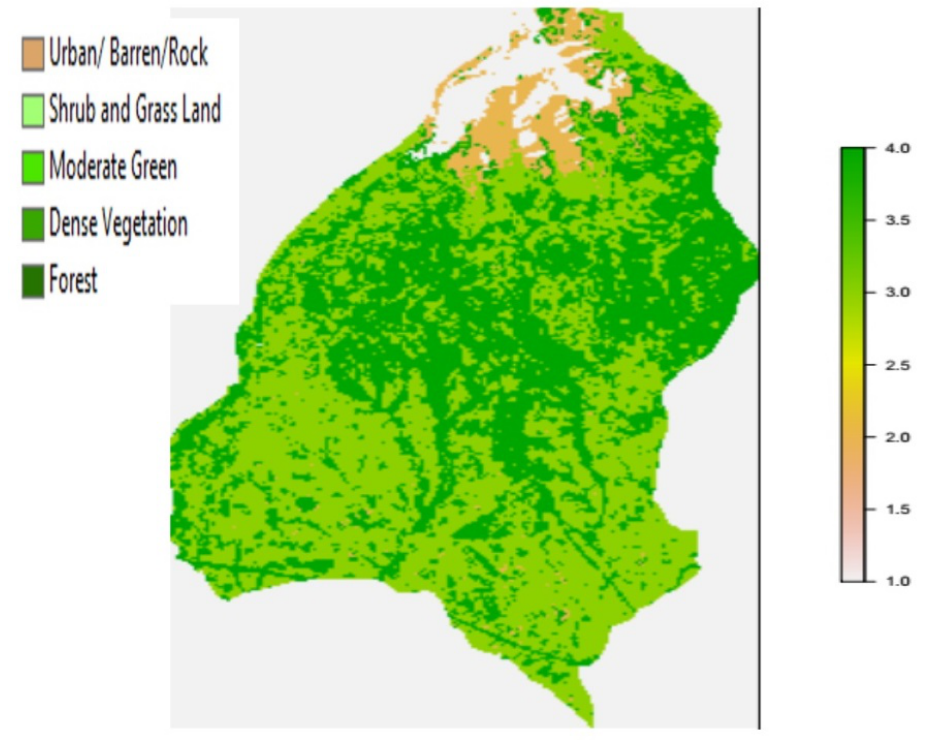
Figure 5. XGBoost model classification